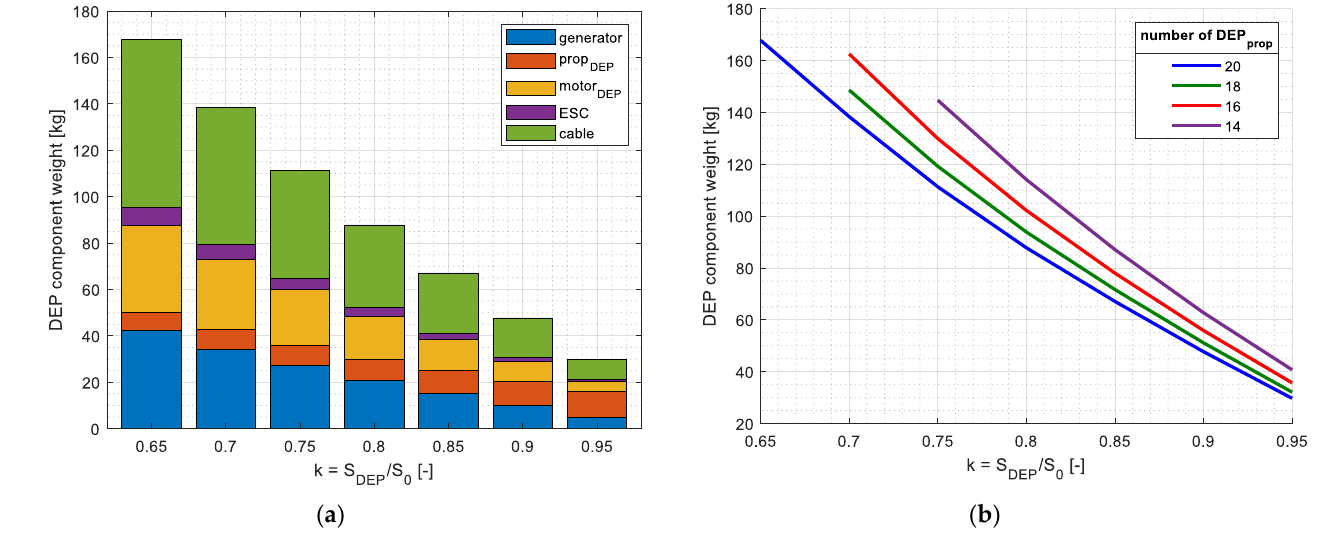
Figure 6. DEP weight distribution for different wing ratios. Part weight distribution for 10 high-lift propellers per half wingspan ( a ); total weight of DEP system for various numbers of high lift propellers ( b ).